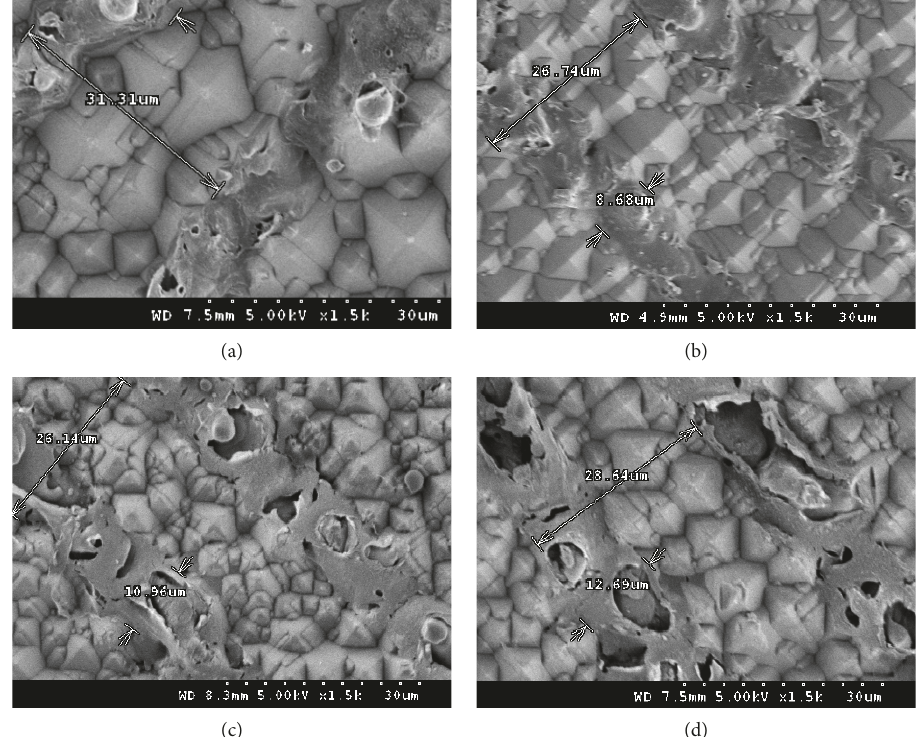
Figure 5: FESEM surface morphology images of backside surfaces of SPMSCs with various laser speeds of (a) 320, (b) 400, (c) 480, and (d) 560 mm/min.